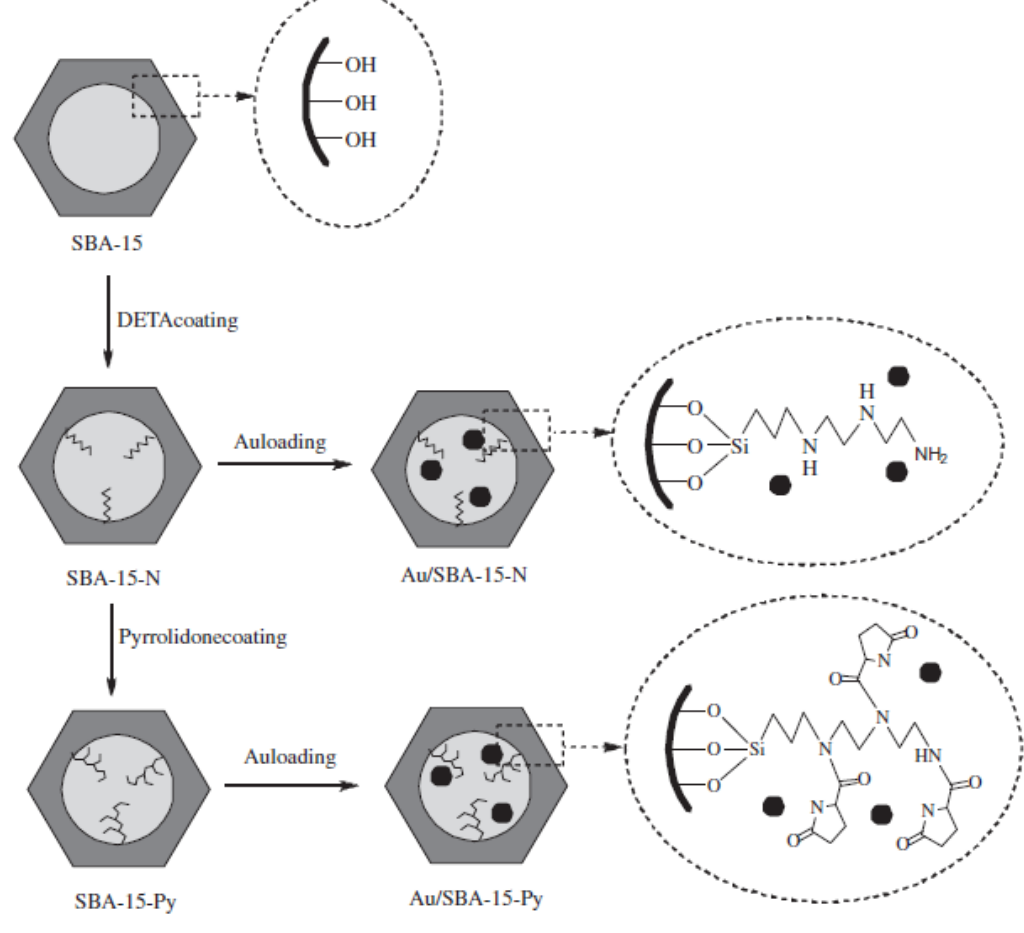
Figure 4. Procedure for the preparation of Au/SBA-15-N and Au/SBA-15-Py catalysts (DETA: N -[3-(trimethoxysilyl)-propyl]diethylenetriamine). Reproduced with permission from Reference [30]. Copyright (2011)